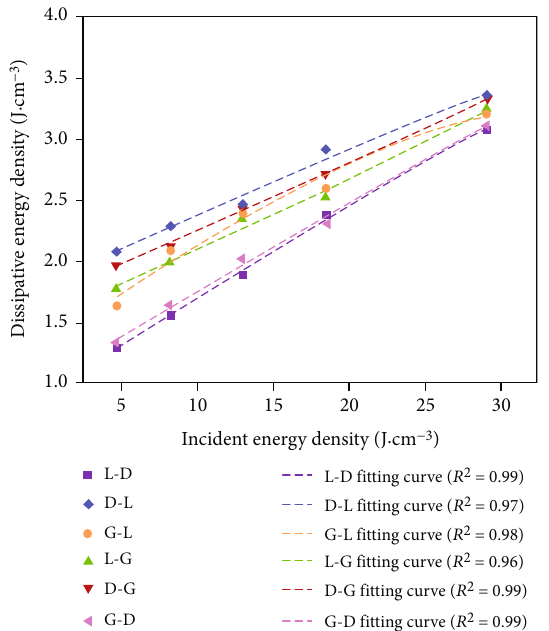
Figure 7: The relationship between the dissipated energy density and the incident energy density.